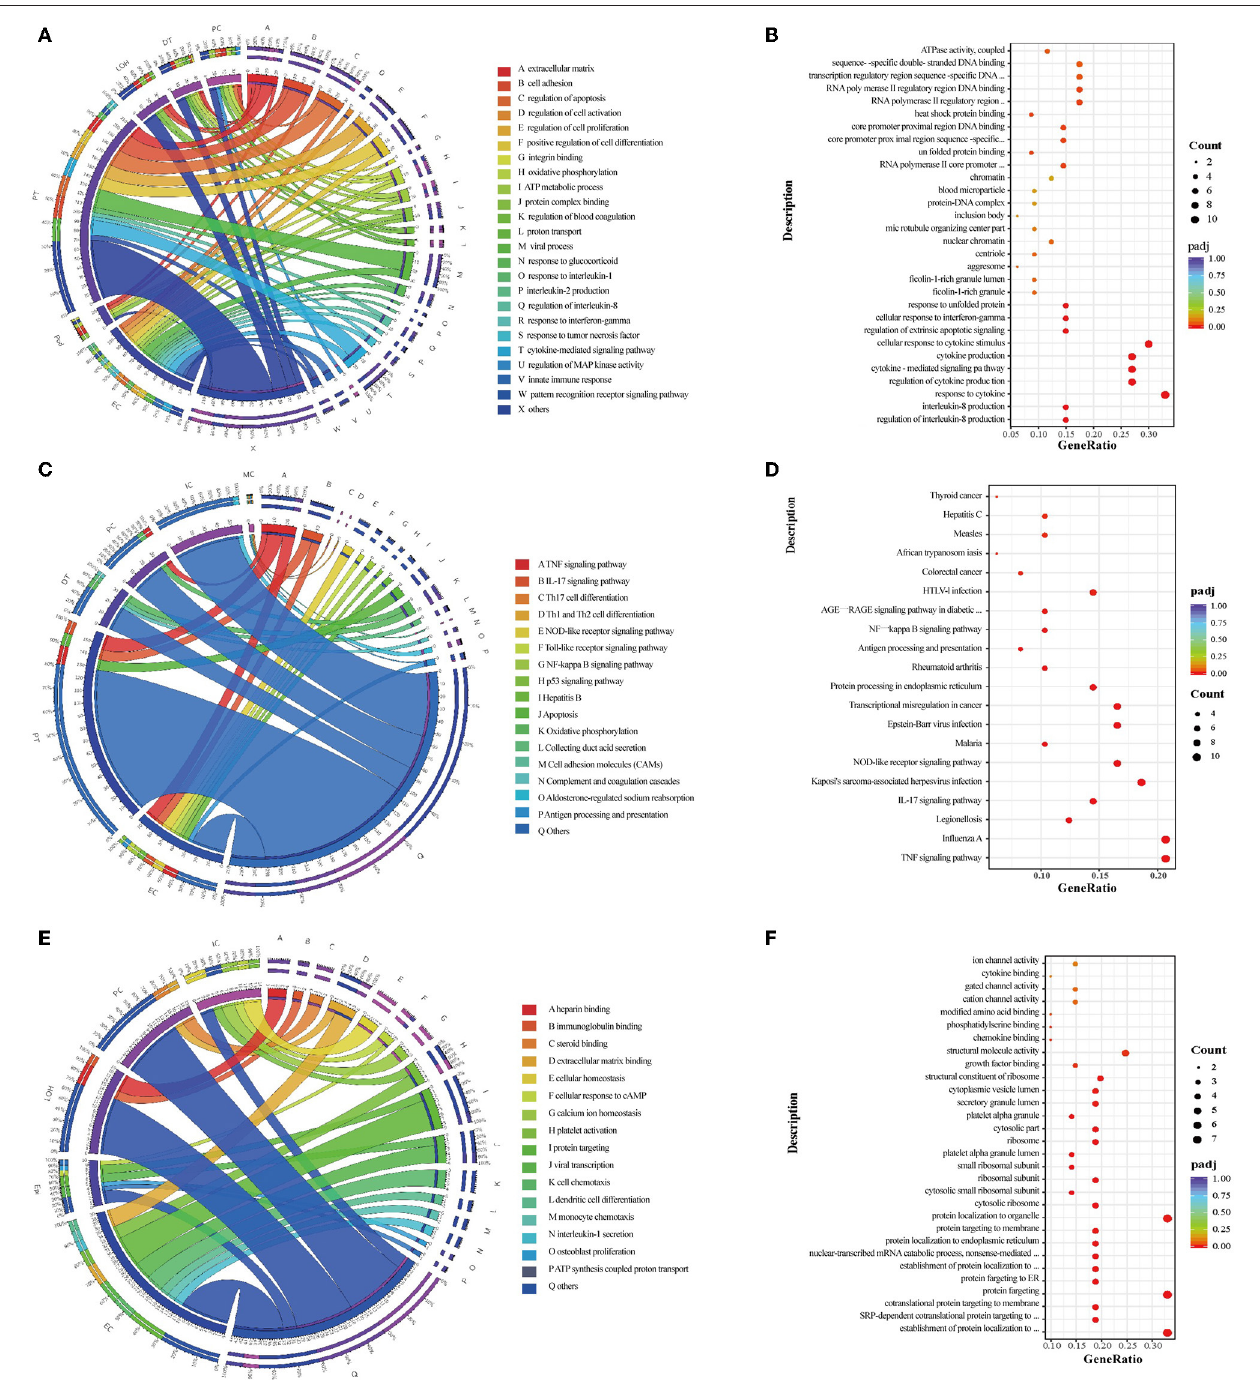
FIGURE 3 | Enrichment analysis in the kidney cells between HBV-MN and healthy/IMN subjects. (A,C) GO and KEGG enrichment shows the biological processes or signal pathways involved in different kidney cells comparing the HBV-MN patients to the healthy donors. The left side of the circle represents different cell types, while the right side represents different biological processes or signaling pathways. The inner-circle represents gene numbers involved in cells or biological processes and signaling pathways, whereas the outer circle represents the proportion of each cell type in biological processes and signaling pathways or the proportion of biological processes and signaling pathways in kidney cells. (B,D) The bubble diagram shows the GO and KEGG enrichment analysis of endothelial cells comparing the HBV-MN patients to the healthy donors, respectively. (E) GO enrichment shows the biological processes involved in different kidney cells, comparing the HBV-MN patients to IMN subjects. (F) The bubble diagram shows the GO enrichment analysis of endothelial cells comparing the HBV-MN patients to IMN subjects.